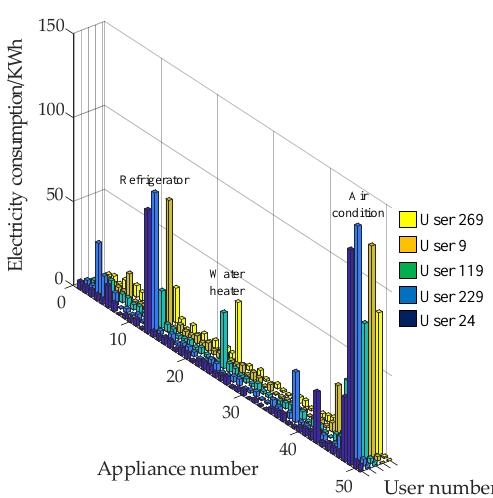
Figure 12. User comparison between di ff erent categories.